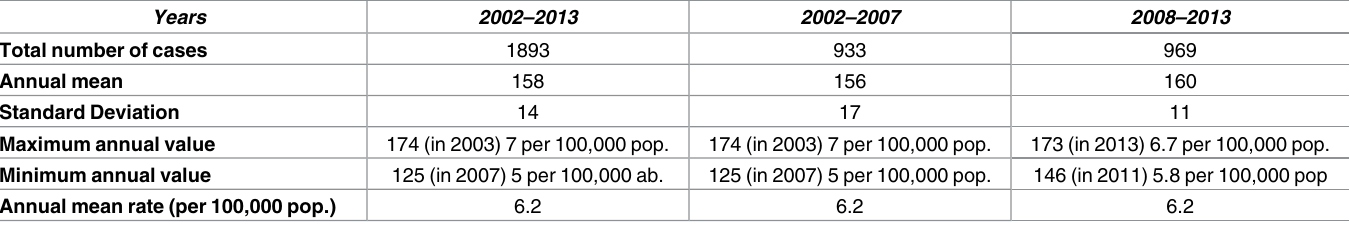
Table 1. Descriptivestatistics on suicides in the province of Milan